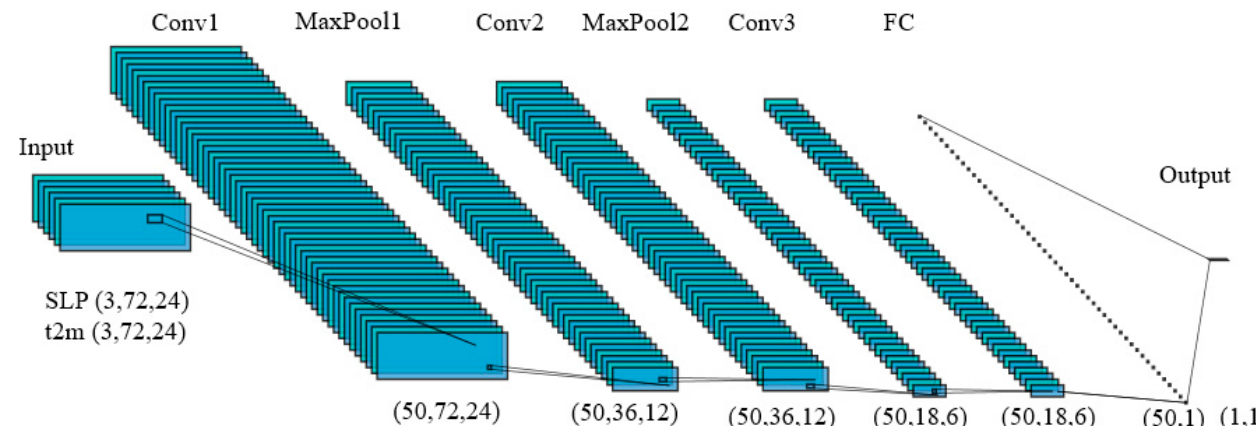
Figure 1. Schematic of the CNN used in this study. The CNN contained one input layer (predictor), three convolution layers (Conv1, Conv2, and Conv3), two max-pooling layers (MaxPool1 and Max- Pool2), one fully connected layer (FC), and one output layer (NCDT). The number of filters in con- volution and hidden layers was set as 50. The variables of the input layer corresponded to the t2m and SLP (sea-level pressure) standardized maps (0°–360° E and 25° S–90° N).